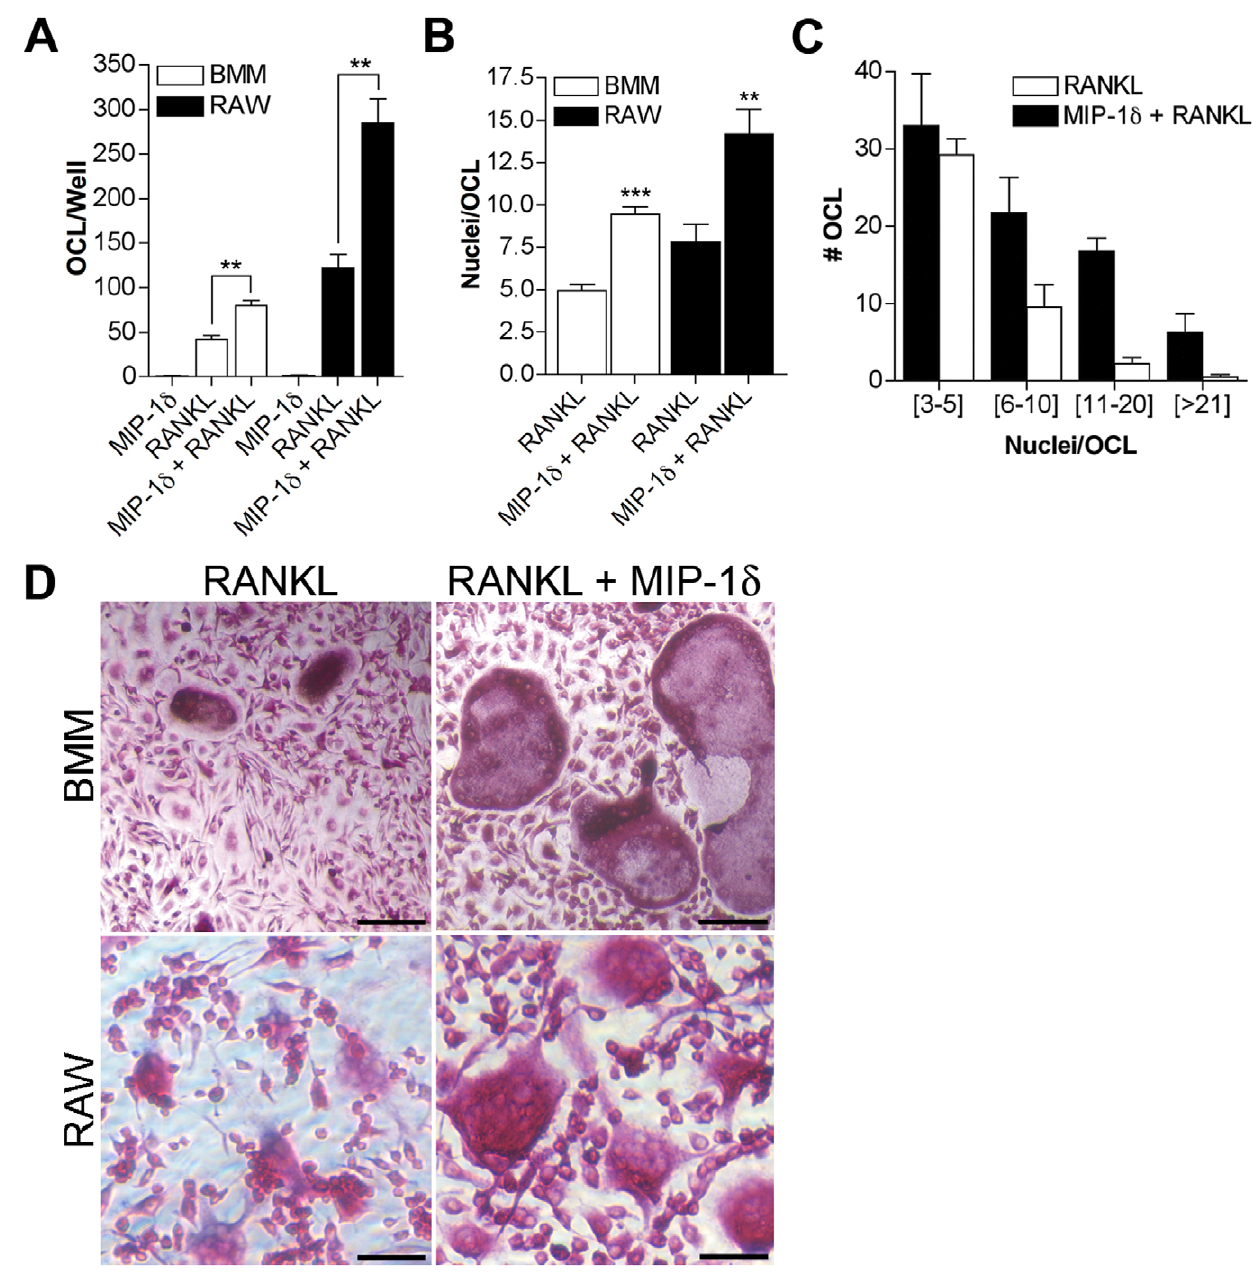
Figure 1. MIP-1 d enhances RANKL-induced osteoclastogenesis in vitro. BMM or RAW 264.7 cells were treated with MIP-1 d (0.1 pg/ml) and RANKL (5 ng/ml) individually or in combination for 7 days. ( A ) OCL formation was assessed by counting the total number of OCL per well under light microscopy ( D , 200X Magnification; Scale bars, 50 m m ) . ( B, C ) Fusion index was determined by counting the number of nuclei per OCL in 15–20 random fields and is reported as (B) the average number of nuclei per OCL and (C) the number of OCL containing a specified range of nuclei per cell (BMM shown, similar results were observed for RAW 264.7). Data are representative of three independent experiments performed in quadruplicate, expressed as the mean (n =12) 6 s.e.m, and were analyzed by unpaired, two-tailed Student’s t-test. **, p , 0.01; ***, p ,